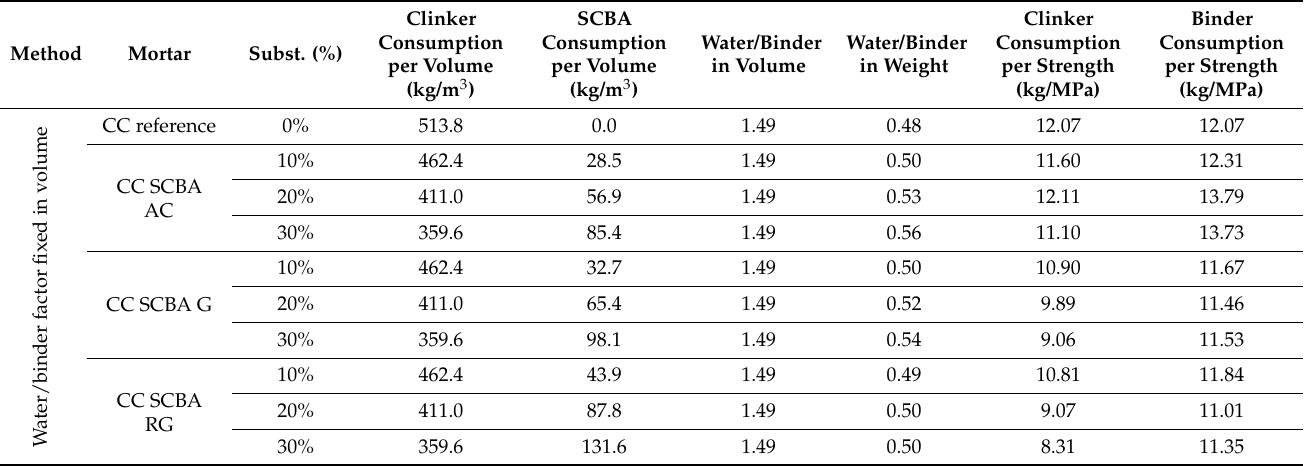
Figure 13. Compressive strength of mortars with the fixed flow. The consumption of binder in a cubic meter of mortar divided by the compressive strength of the mortars with a fixed water/volume factor is shown in Table 5. It should be noted that the SCBA consumption per volume (kg/m 3 ) is detached from the X axis to fa- cilitate reading, but the vertical length of the gray bar represents the amount of ash per cubic meter of mortar. It is possible to observe that the lowest Portland cement clinker consumption was 8.31 kg/MPa for the mortar with a 30% replacement of re-fired and ground ash compared to the consumption of 12.07 kg/MPa of the reference composite; thus, a reduction in clinker consumption of approximately 30% for the equivalent com- pressive strength was obtained. Table 5. Comparisons between cement or binder consumption by compressive strength of mortars with fixed water/binder factor in volume.